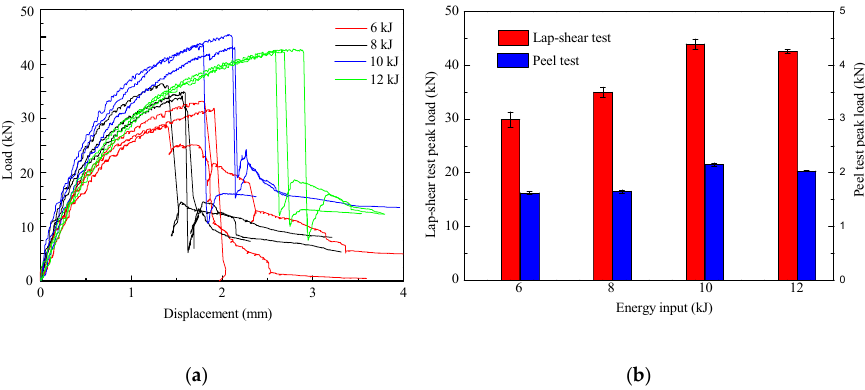
Figure 5. Lap-shear and peel test results at 6 kJ, 8 kJ, 10 kJ, and 12 kJ energies input. ( a ) Load– displacement curves of lap-shear test; ( b ) Lap-shear and peel average load.